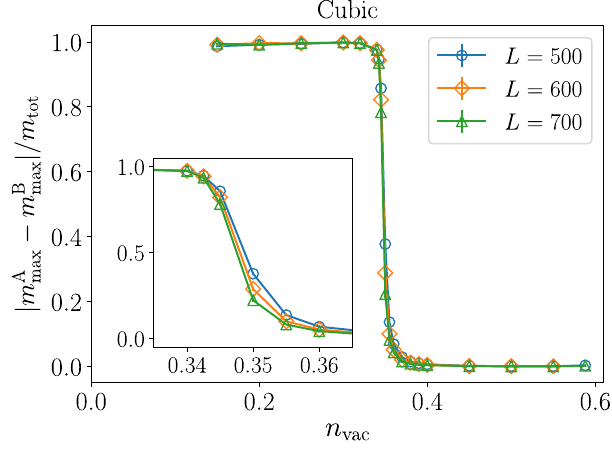
− m B j =m displays a max max tot